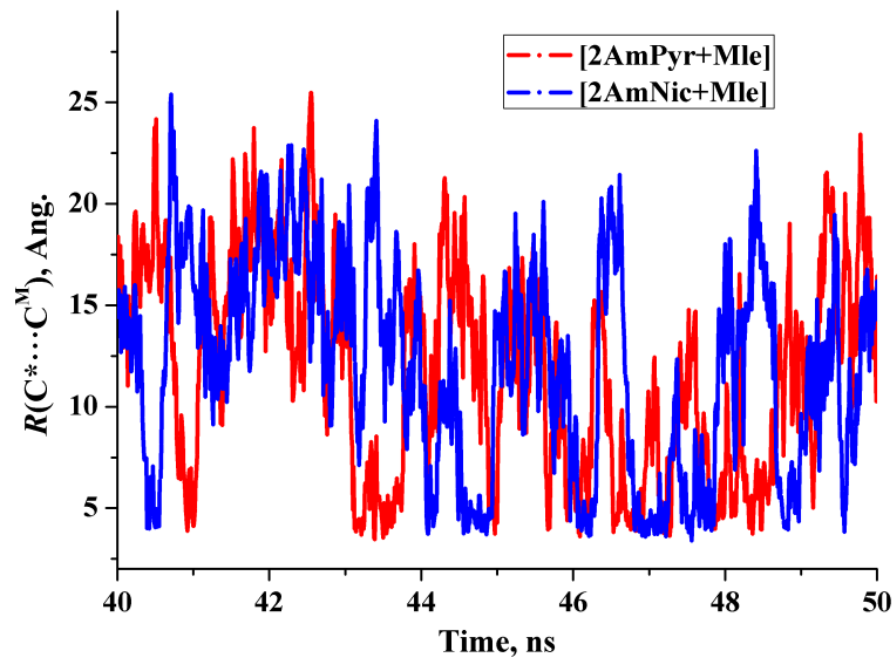
Figure 2. Distance R[C* ··· C M ] on the part of the MD trajectories from 40 to 50 ns.